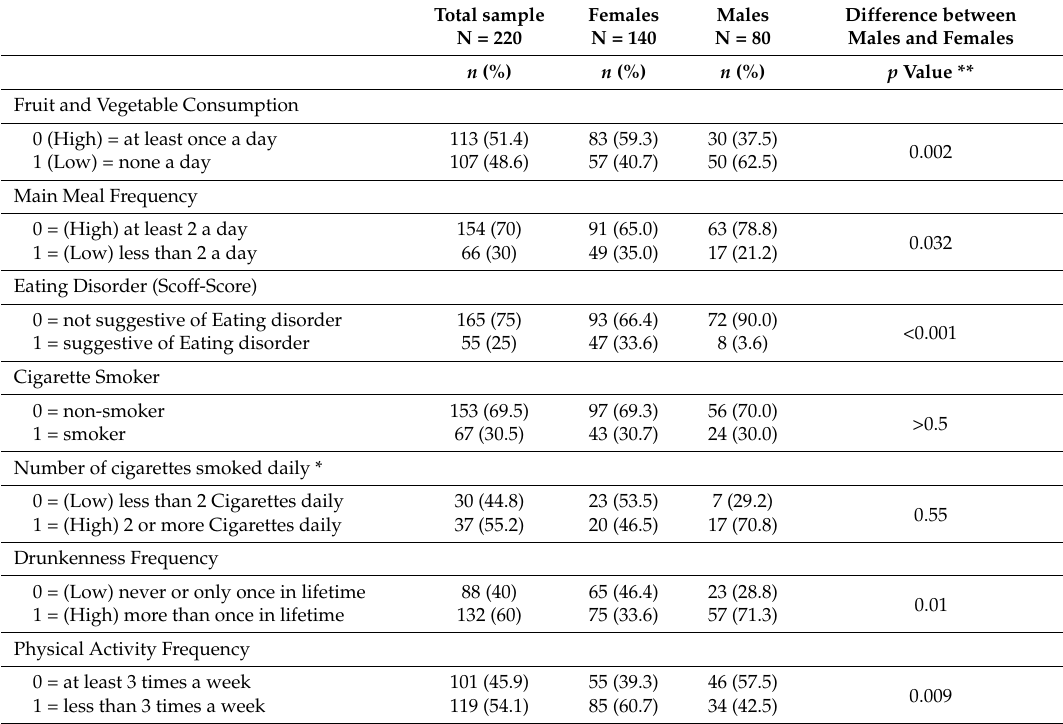
Table 2. Percentage frequency of transposed dichotomous health related variables of total sample and by